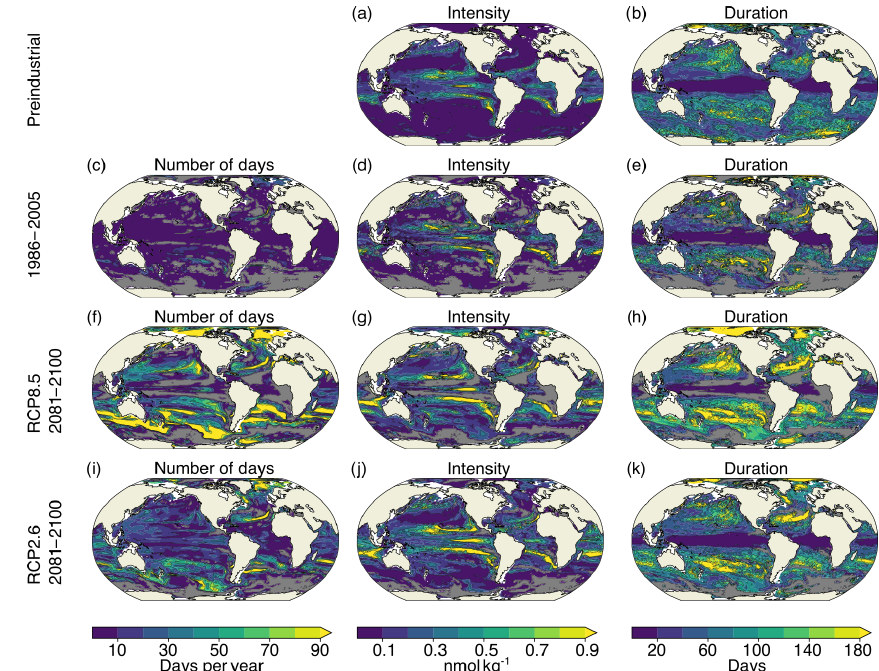
Figure A4. Simulated characteristics of [H + ] extreme events at 200m for the preindustrial period (a, b) , 1986–2005 ensemble mean (c–e) , RCP8.5 2081–2100 ensemble mean (f–h) , and RCP2.6 2081–2100 ensemble mean (i–k) . The extreme events are defined with respect to shifting baselines. Gray colors represent regions where no ensemble member simulates extremes. The black contours highlight the pattern